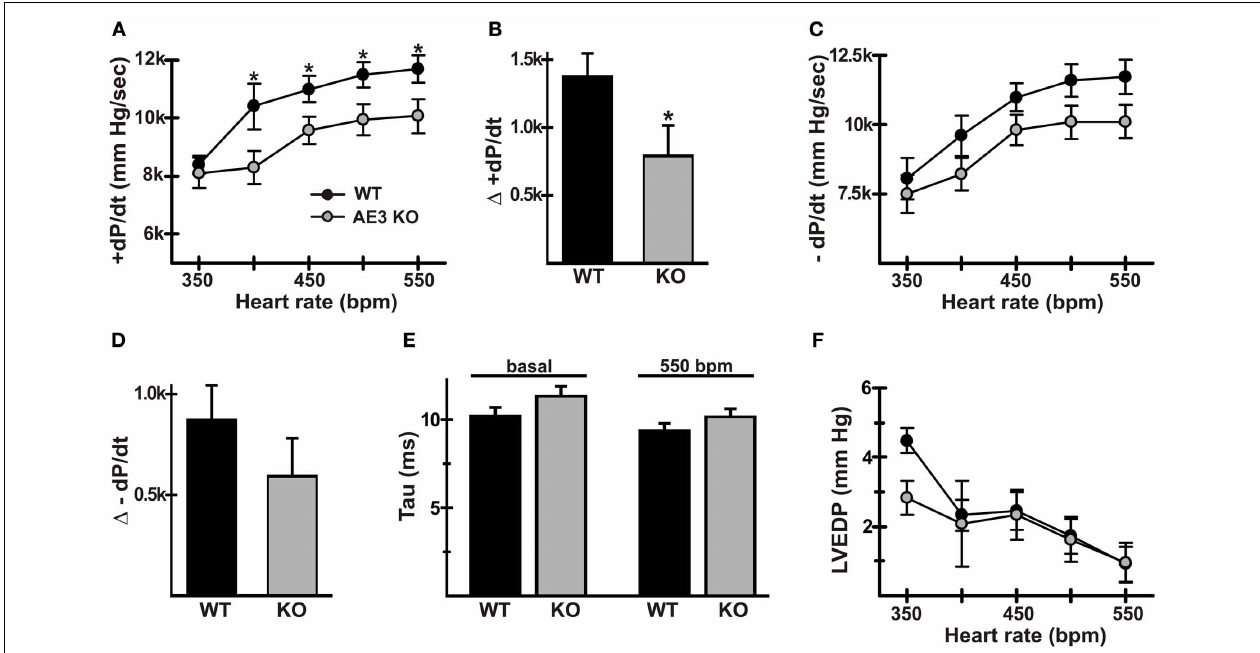
± 9bpm, p = 0 . 6); (C) changes in − dP/dt upon pacing; (D) changes in − dP/dt represented as (cid:2) − dP/dt and calculated as the difference between values at 550bpmandbaselineheartrate; (E) Tau(relaxationtimeconstant)valuesunder basalandpacedconditions; (F) changesinleftventricularenddiastolicpressure (LVEDP) upon pacing. Values shown are means ± SE, n = 19 mice for each genotype except for dP/dt values at 350bpm ( n = 4 for each genotype) and 400bpm ( n = 9 for each genotype). ∗ p < 0 .